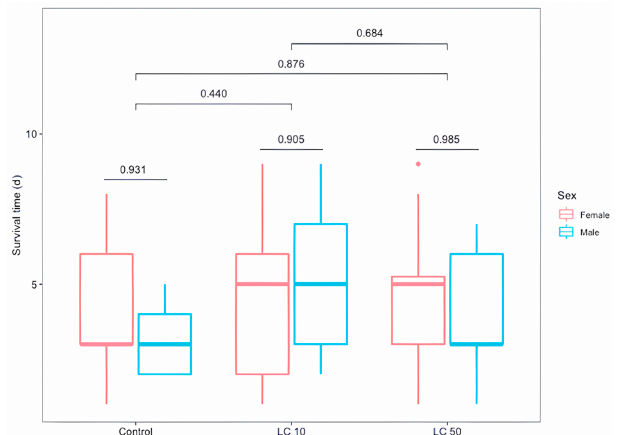
Figure 2. Emerged Diachasmimorpha longicaudata adults reared from Anastrepha ludens larvae first parasitized by the wasp and then exposed to two sublethal concentrations (LC 10 and LC 50 ) of M. robertsii V3-160 strain. Numerical values represent the p -value of paired tests. Insects 2021 , 12 , x FOR PEER REVIEW